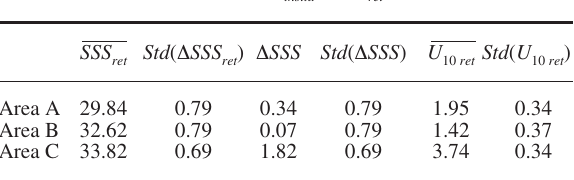
Table 1. – Retrieved parameters for the three different areas from LEG2, after averaging 300 T measurements. B – SSS ∆ SSS = SSS insitu ret